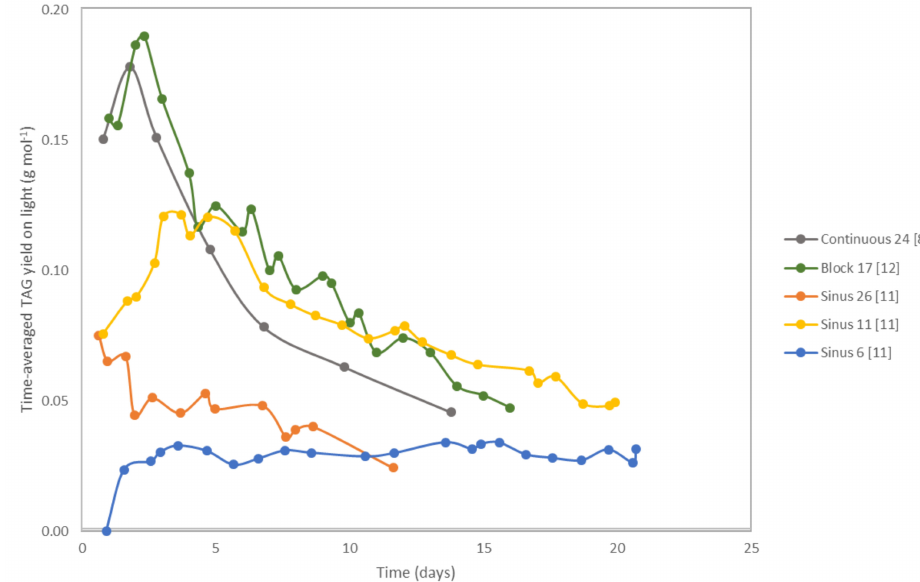
Figure A1. Time-averaged TAG yield on light (g TAG mol ph − 1 ) for the different biomass-specific photon supply rates and light regimes from the moment of nitrogen starvation